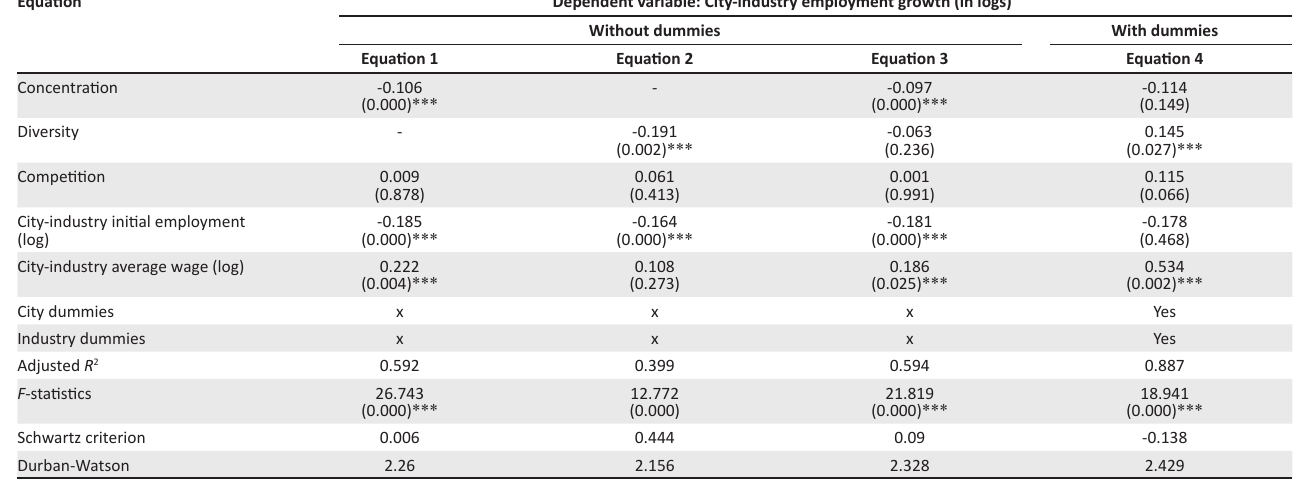
TABLE 12: Main results of KwaZulu-Natal city-industry economies. Equation Dependent variable: City-industry employment growth (in